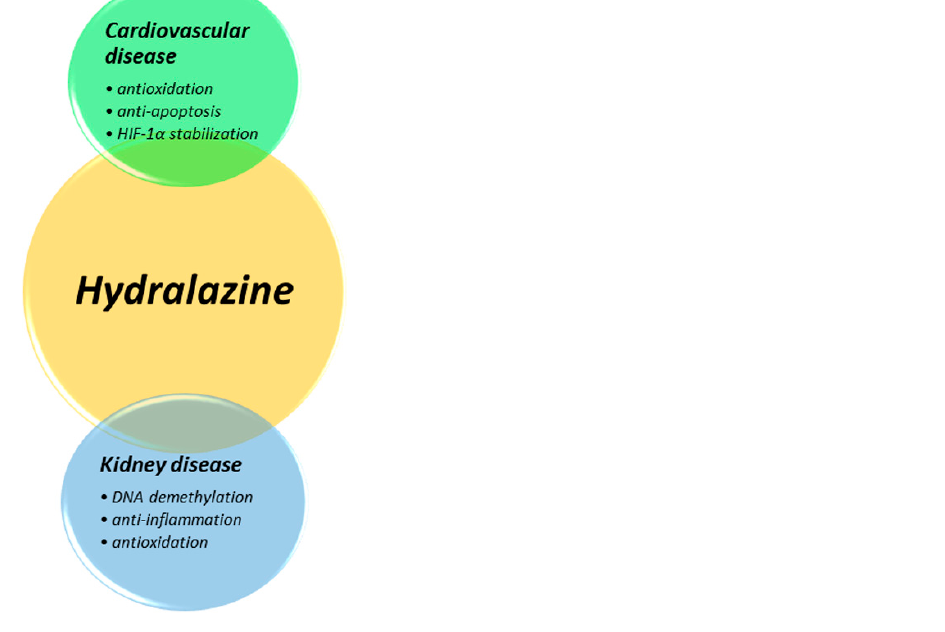
Figure 1. Overview of the systemic impacts of hydralazine and its potential